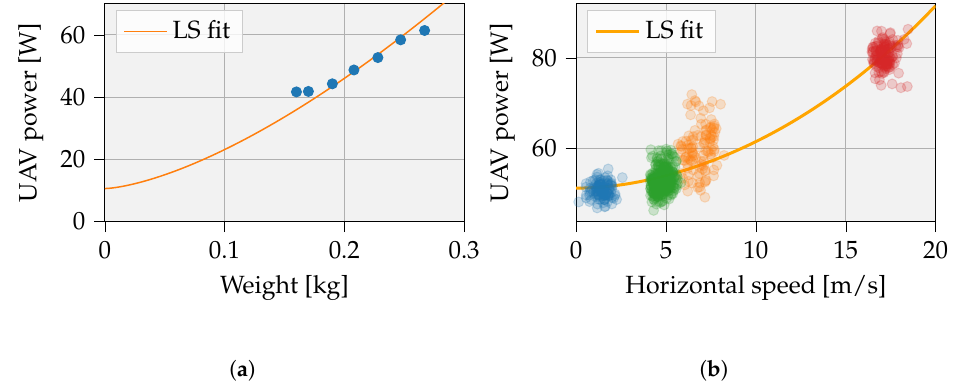
Figure 4. Experiment 1 gauged the hovering power related to UAV weight and payload. ( a ) LS fit on hovering data; Experiment 3 measured the UAV power and angle related to the horizontal speed. ( b ) LS fit on horizontal flight data. ( m payload = 50g).